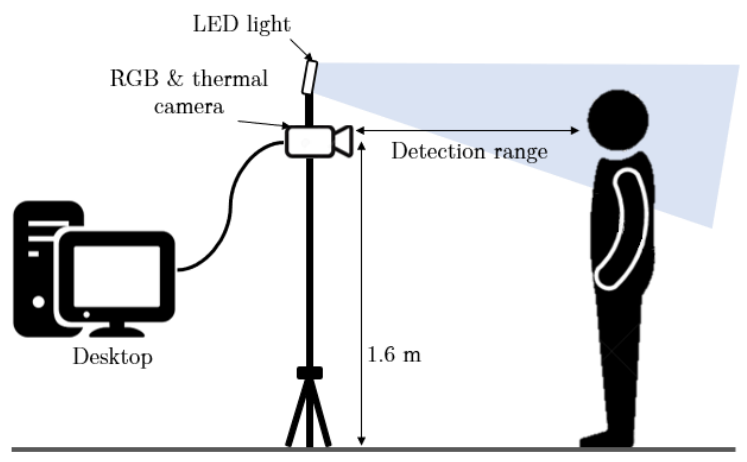
Figure 1. The illustration of vital signs measurement experiment